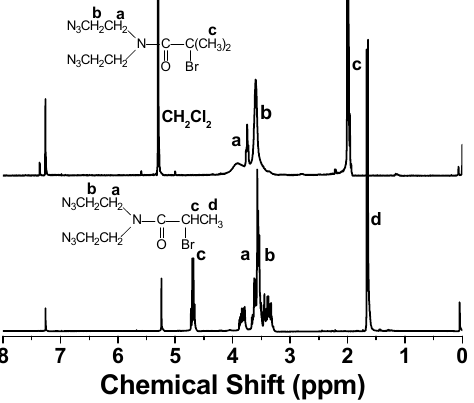
Figure 1. The 1 H-NMR spectra of AECPA (lower) and AEBIA (upper) in CDCl 3 .